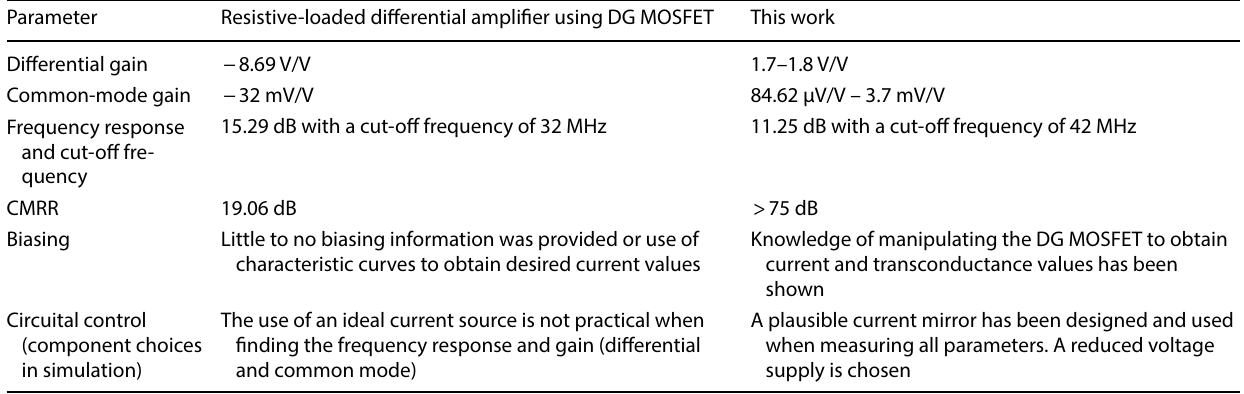
Table 7 Comparative analysis of differential amplifiers designed using DG MOSFET